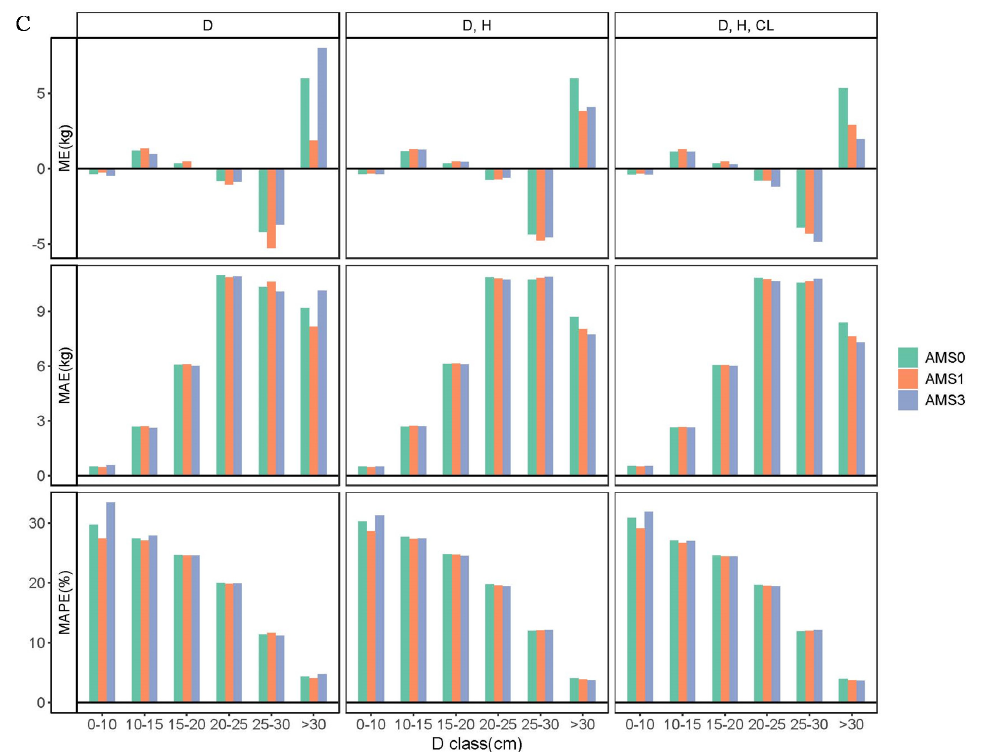
Figure 4. Comparison of model performances for the AMS0, AMS1 and AMS3 based on D, combination of D and H, and combination of D, H, and CL across diameter classes in total biomass ( A ), aboveground biomass ( B ) and crown biomass ( C